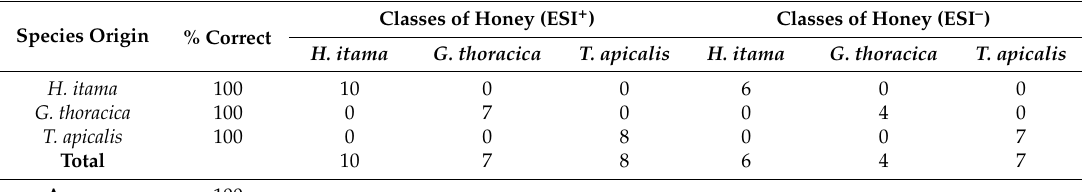
Table 2. The misclassification table for PLS-DA model of m / z values of ESI + and ESI − precursor ions. Species